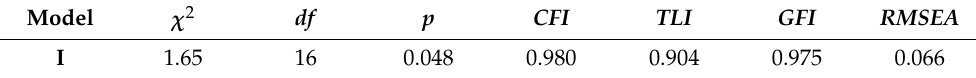
Table 4. Matching quality indices of the approximate model (N =